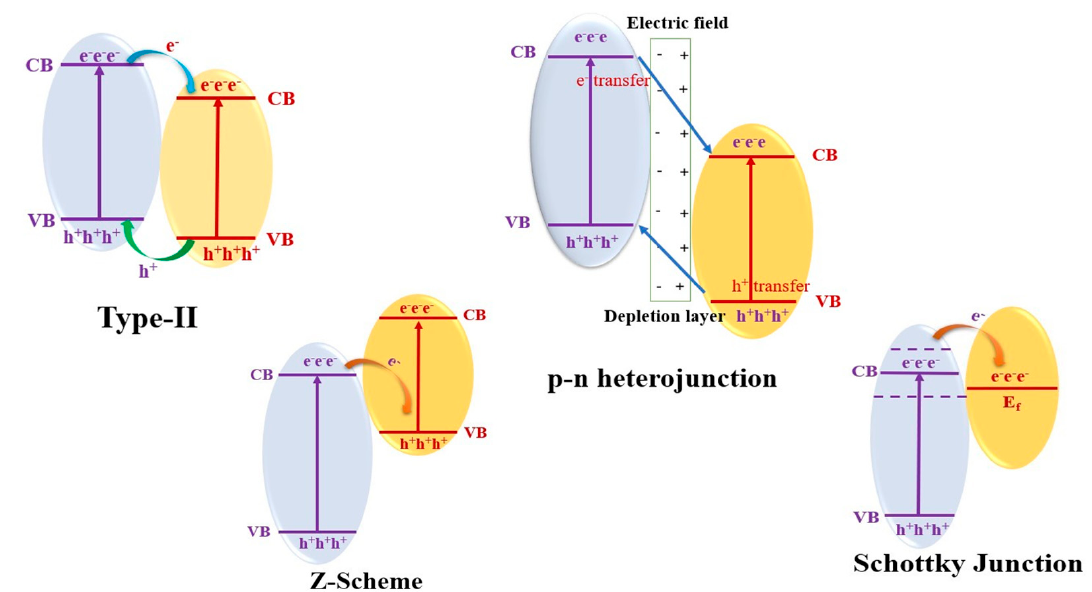
Figure 3. Schematic diagram of different types of heterojunctions.